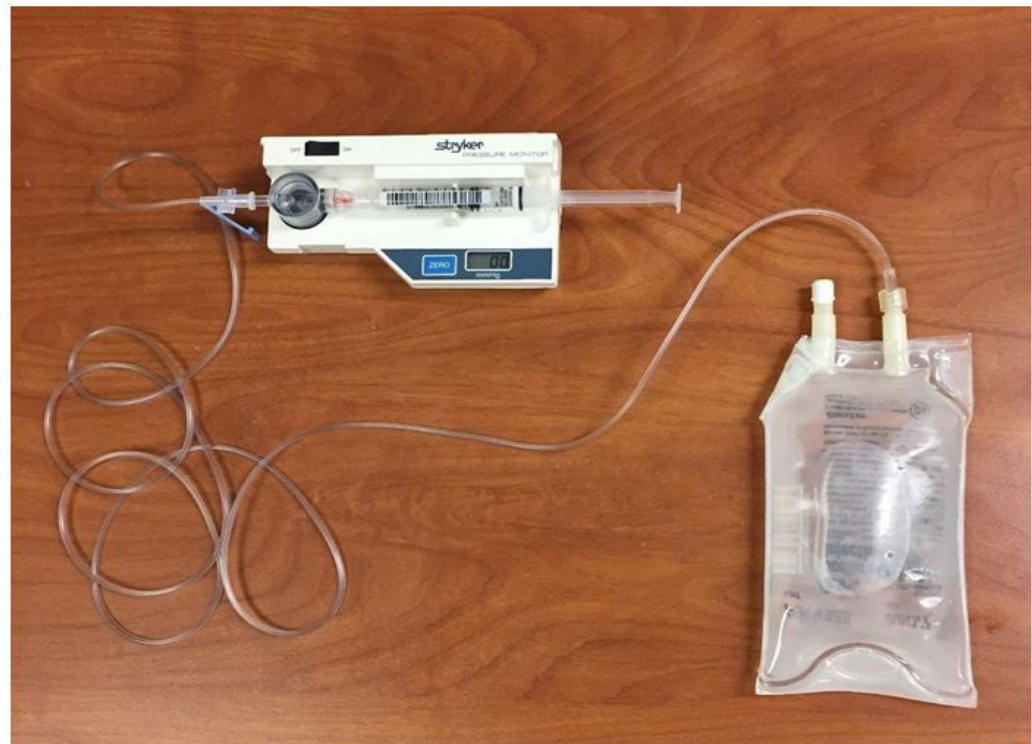
Figure 2. Noninvasive pressure measurement setup, showing 100mL bag of normal saline connected to Stryker pressure meter via standard intravenous (IV)